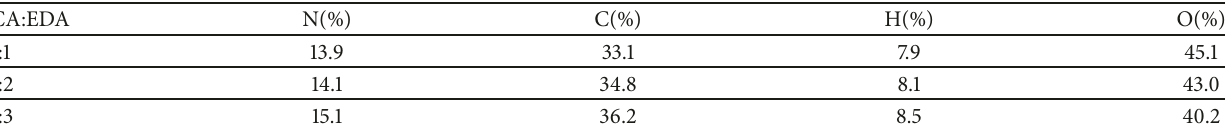
Figure 4: (a) Full-scale XPS spectrum of N-GQDs prepared by citric acid: ethylenediamine=1:3; (b) high resolution XPS spectra of C1s; (c) high resolution XPS spectra of N1s. Table 1: Elemental analysis table of N-GQDs prepared by different ethylenediamine